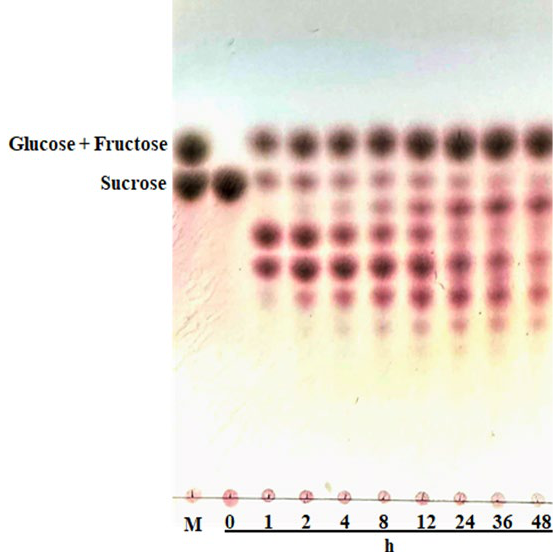
Figure 6. Potential application of AlFFase3 in FOS preparation by AlFFase3. The reaction mixture, containing 200 mg/mL of sucrose in 50 mM sodium phosphate buffer (pH 6.5) and 10 U/mL of AlFFase3, was incubated at 40 °C. Lane M—a mixture of fructose, glucose and sucrose; the other lanes—end products from hydrolysis of sucrose at different time s.